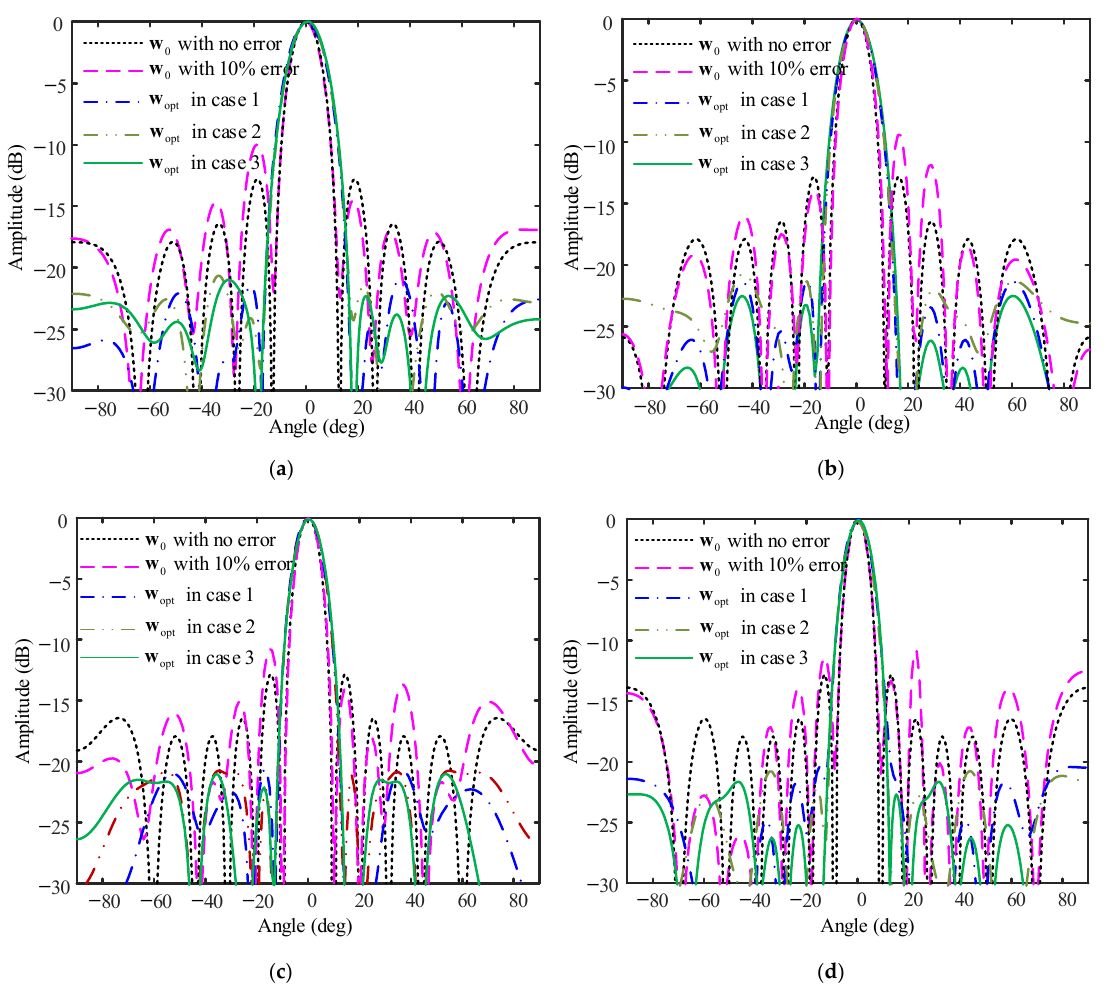
Figure 8. Normalized patterns before and after applying the proposed low PSLL beampattern synthesis approach at four different frequencies ( a ) 7 GHz, ( b ) 8 GHz, ( c ) 9 GHz and ( d ) 10 GHz. Table 6. The PSLLs after applying the proposed low PSLL beampattern synthesis approach at 7 GHz, 8 GHz, 9 GHz and 10 GHz.